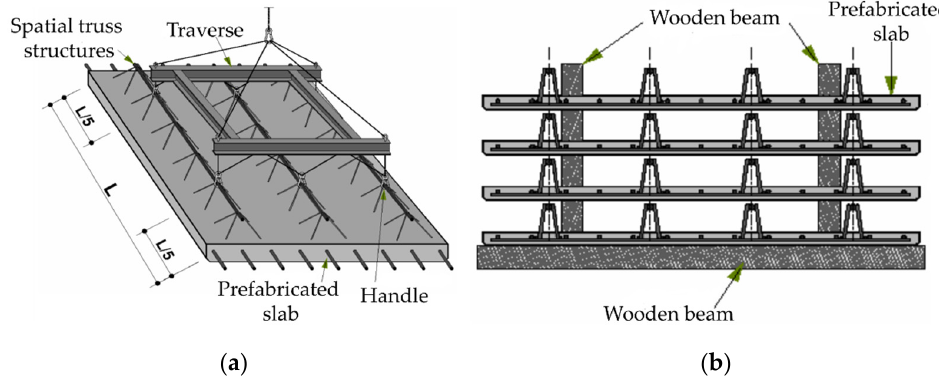
Figure 4. Filigree ceiling: ( a ) transport (assembly); ( b ) storage.